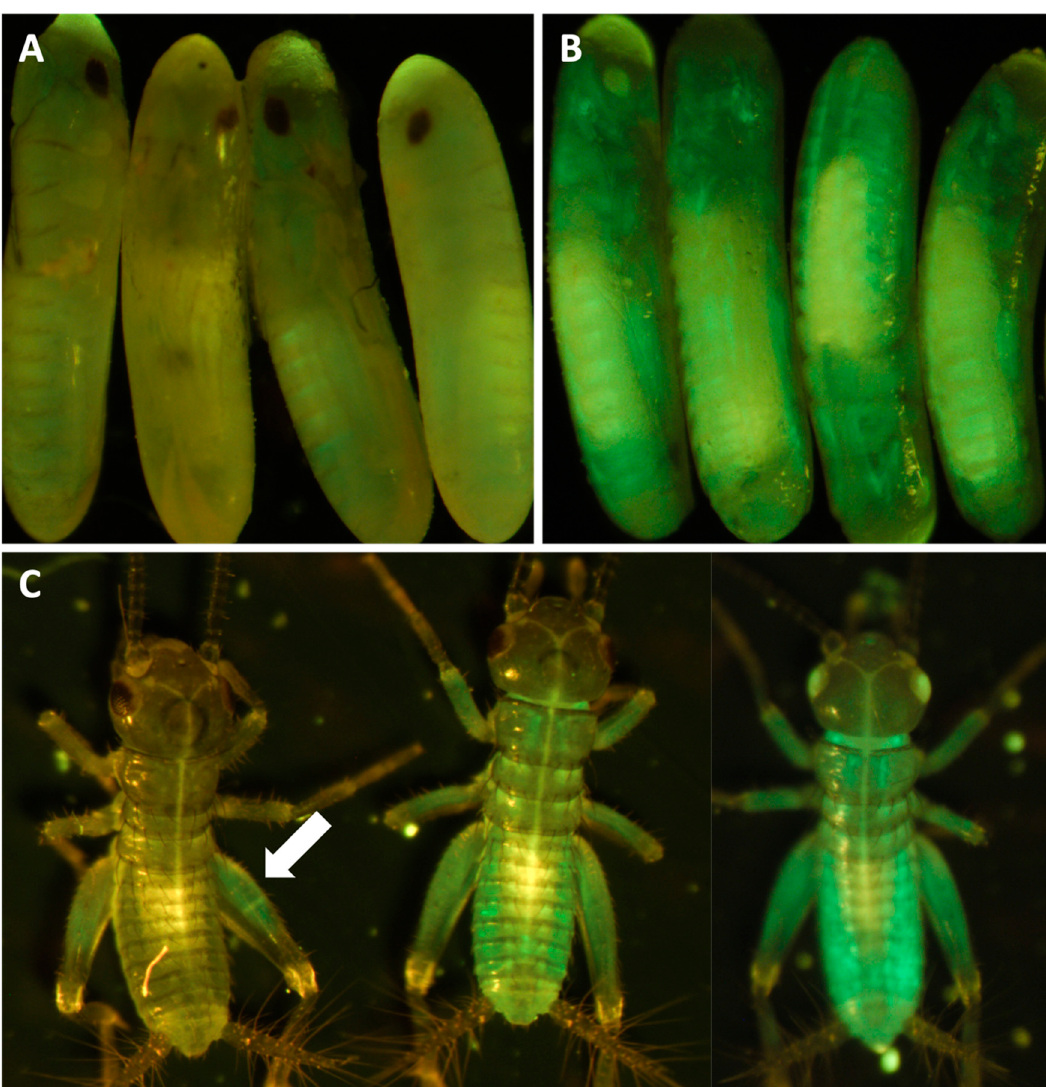
Figure 9. G 1 A. domesticus with GFP expression. ( A ) #1 G 1 eggs with some GFP expression. ( B ) #3 G 2 eggs with GFP expression. ( C ) GFP crickets from #1 (left) and #3 heterozygous and homozygous (middle and right) crickets. The arrow indicates EGFP expression in the cricket leg muscle. Note: Homozygous cricket with white eye phenotype.